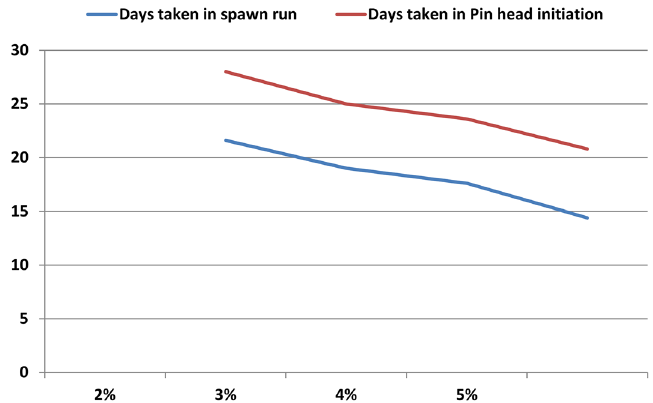
Figure 7. Average days taken in spawn run completion and average days taken to pin head initiation from different spawn rates.